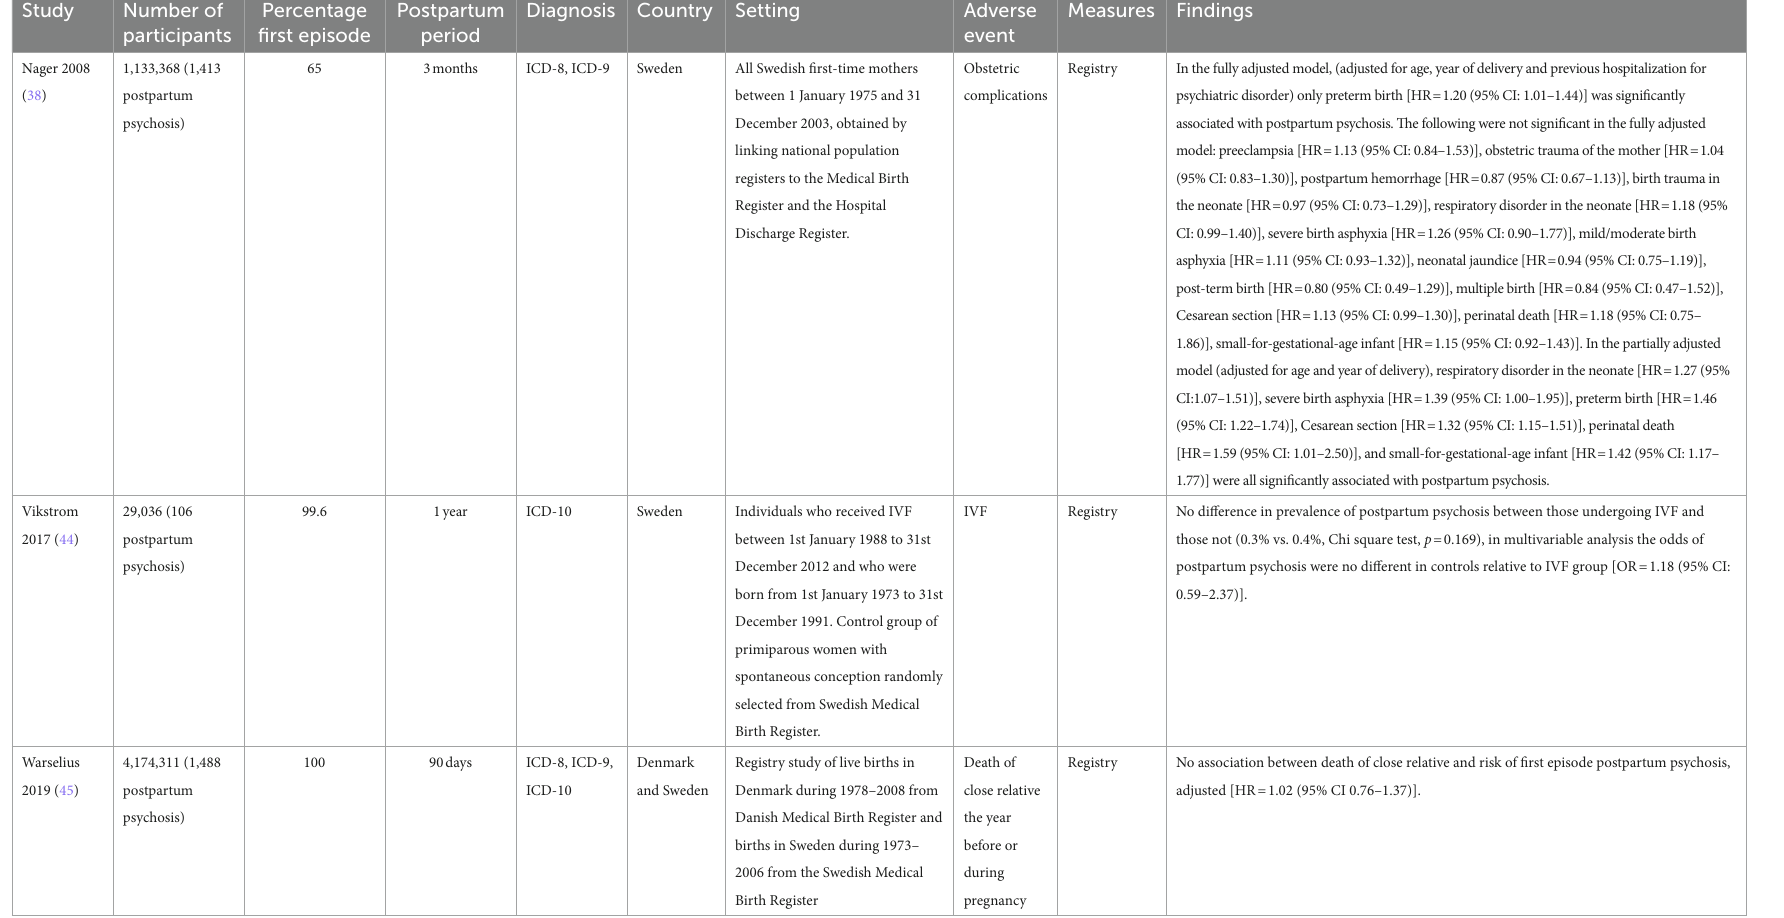
In the fully adjusted model, (adjusted for age, year of delivery and previous hospitalization for psychiatric disorder) only preterm birth [HR = 1.20 (95% CI: 1.01–1.44)] was significantly associated with postpartum psychosis. The following were not significant in the fully adjusted